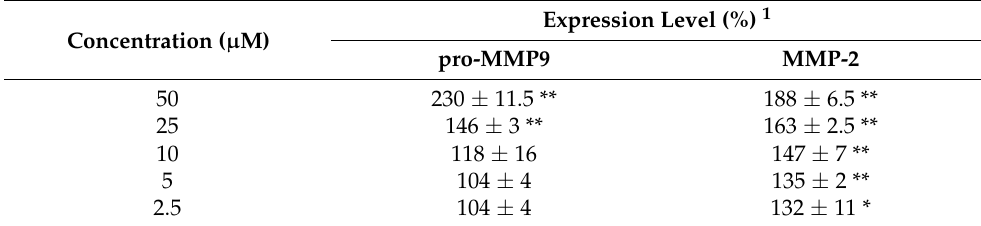
Figure 5. Effects of PA at various concentration. Table 1. MMP-2 and MMP-9 activation by PA at various concentrations. Table 1. MMP-2 and MMP-9 activation by PA at various concentrations.